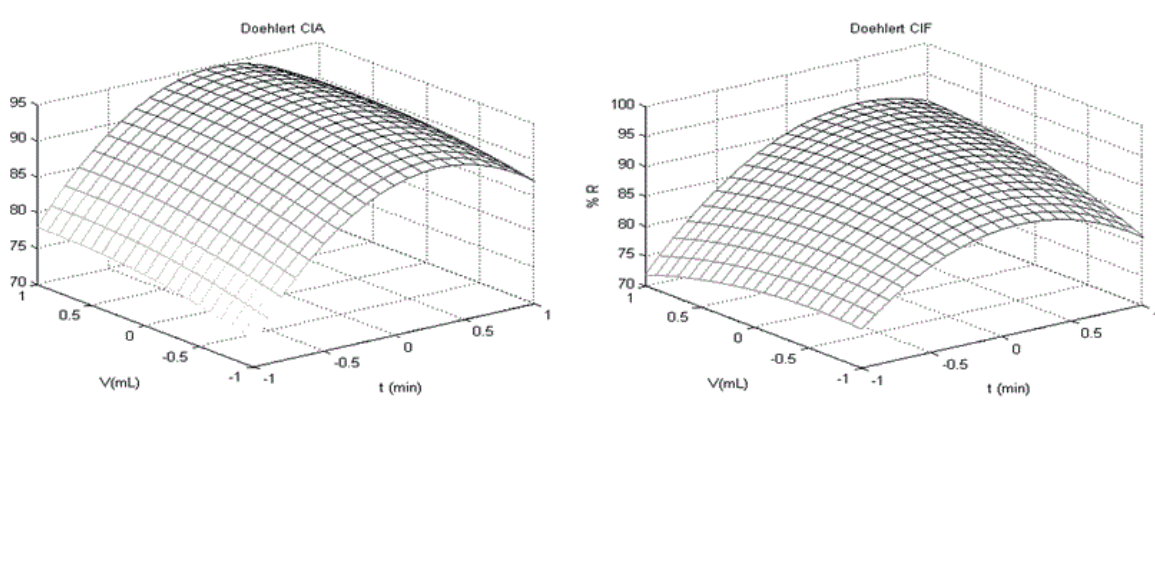
Figure 3. Response surfaces (RSMs) obtained using Doehlert design for recovery (%R) as response; volume of solvent ( V ) and time of agitation ( t ) were the significant factors obtained from